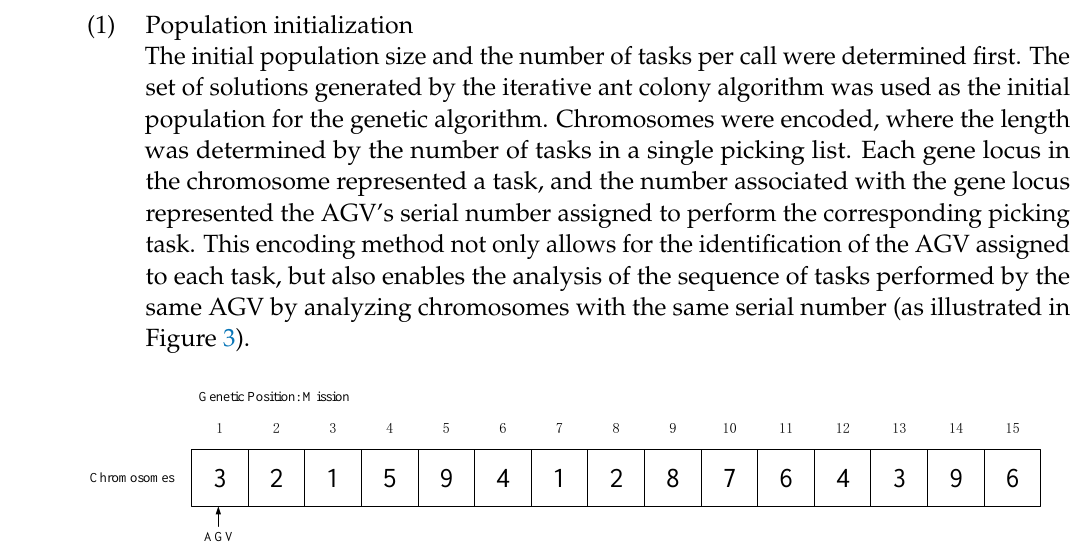
Figure 3. Chromosome coding